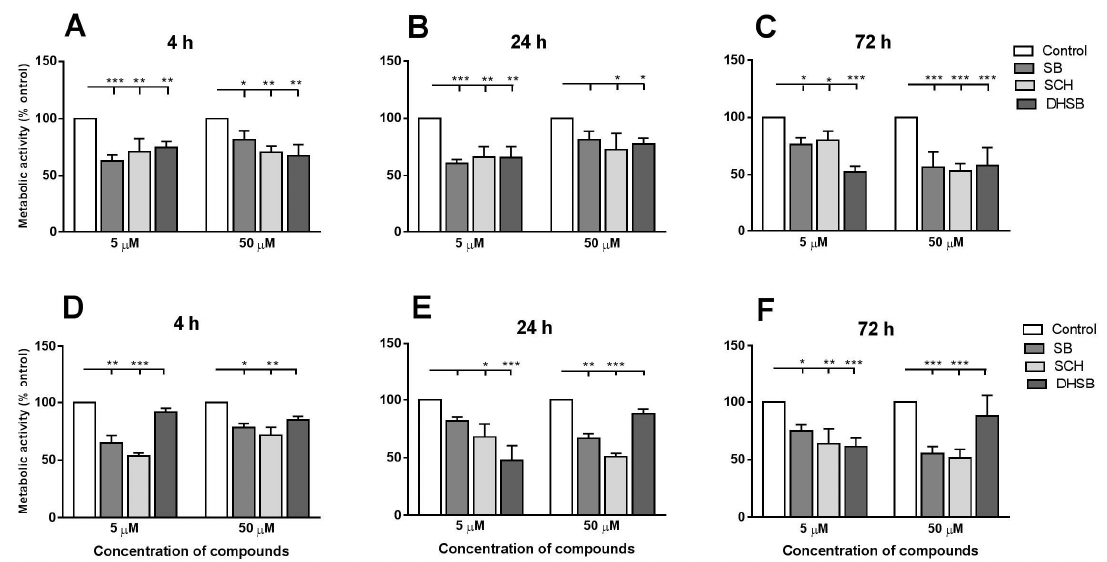
Figure 2. Concentration- and time-dependent effect of SB, SCH and DHSB on metabolic activity of larvae under aerobic ( A – C ) and hypoxic ( D – F ) conditions. Larvae were treated with 5 µ M and 50 µ M FLs, and MTT was added 4 h prior to formazan extraction. The results represent means ± SD from three experiments done in triplicates/group and are expressed as the proportions (%) of absorbance in treated groups related to the absorbance in the control group (100%). Significantly different values from controls are shown as * p < 0.05, ** p < 0.01, *** p < 0.001. (SB) silybin; (SCH) silychristin; (DHSB) dehydrosilybin.